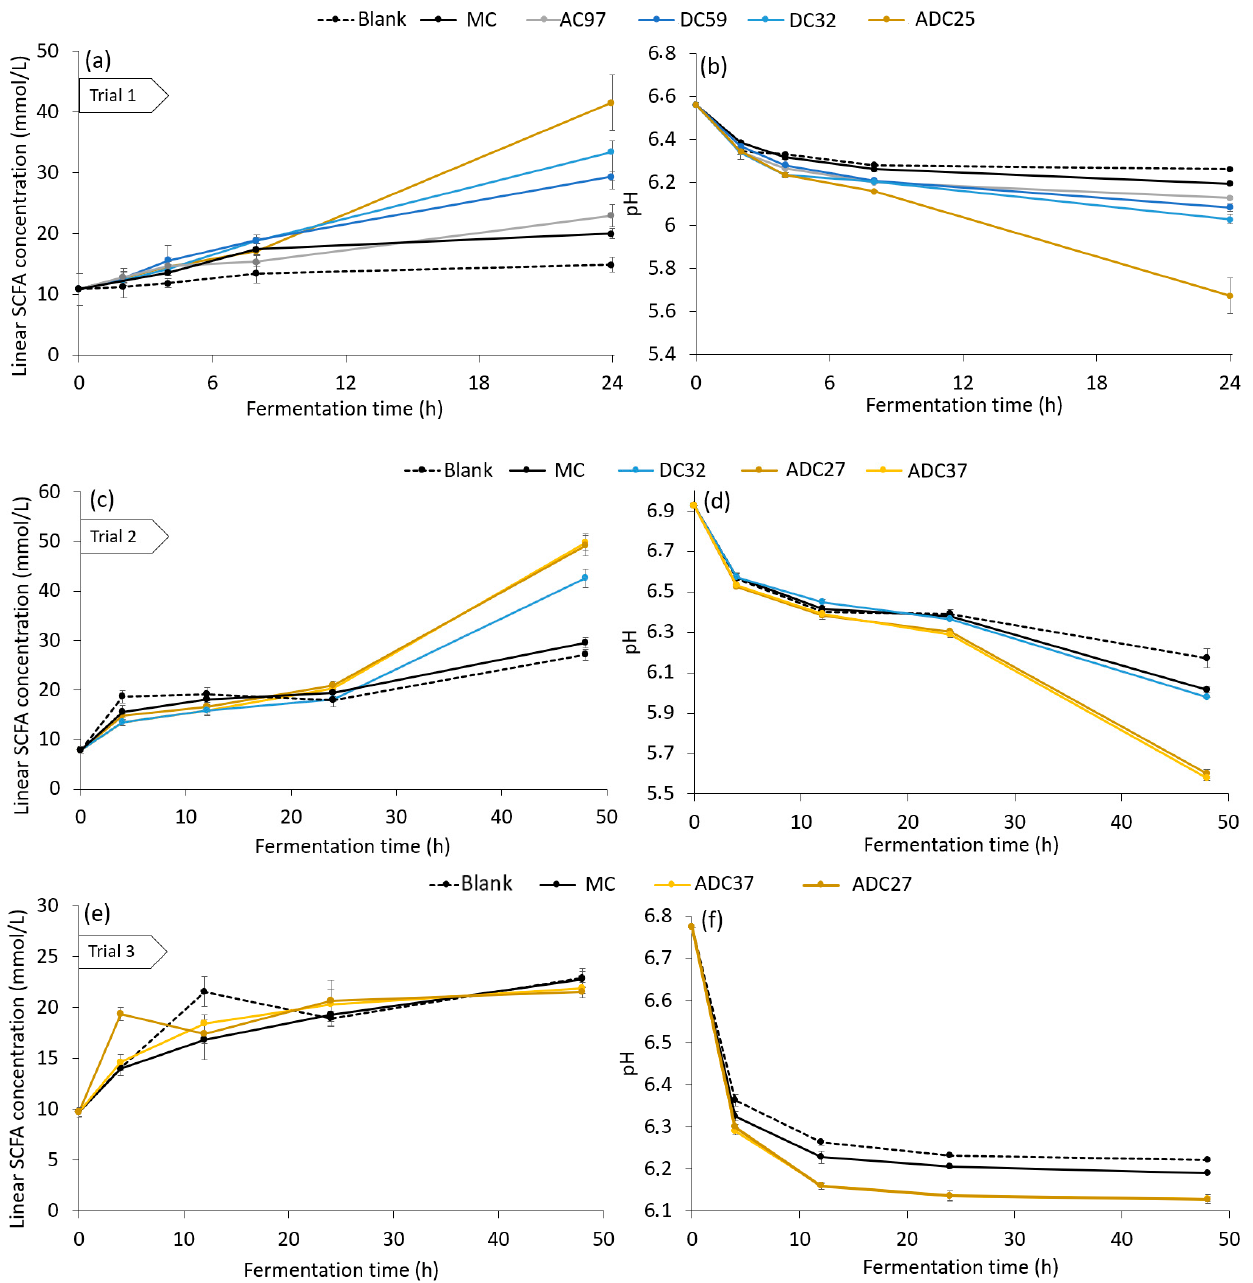
Figure 4. Linear short-chain fatty acid (SCFA) concentration ( a , c , e ) and pH ( b , d , f ) of cellulose-enriched fecal inocula in three independent batch in vitro fermentations with pooled human feces, in function of incubation time. ACxx, DCxx or ADCxx represents the fecal inoculum with an amorphized cellulose, depolymerized cellulose or amorphized depolymerized cellulose with an average DP of xx added.